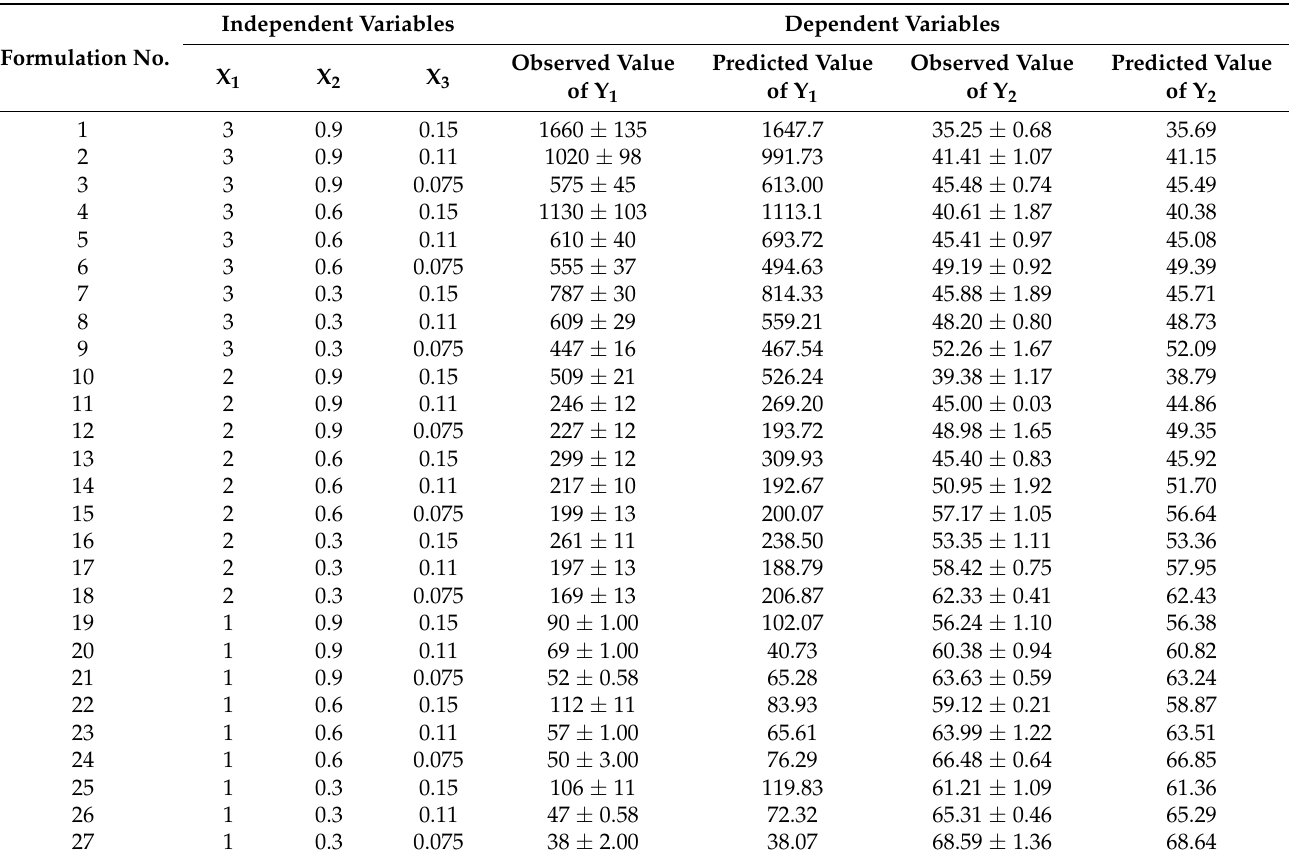
Table 2. Observed responses in (3 3 ) factorial experimental design for BH in situ forming gel formulations.